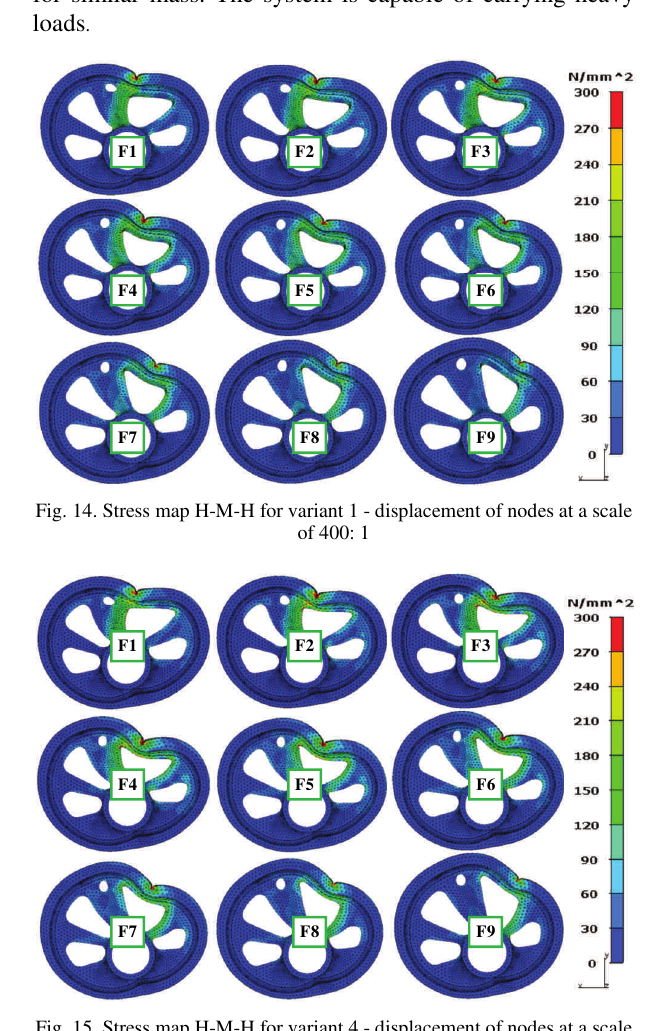
Fig. 15. Stress map H-M-H for variant 4 - displacement of nodes at a scale of 400: